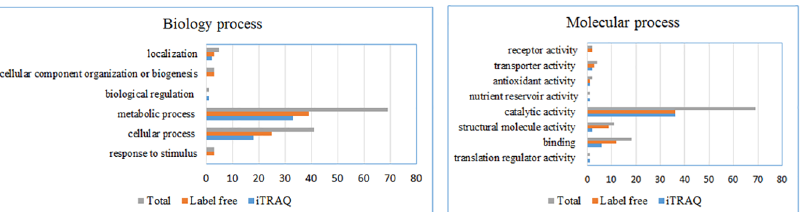
Fig 2. Enrichment analysis results of possible target-related proteins found in label free, iTRAQ, and both two methods.